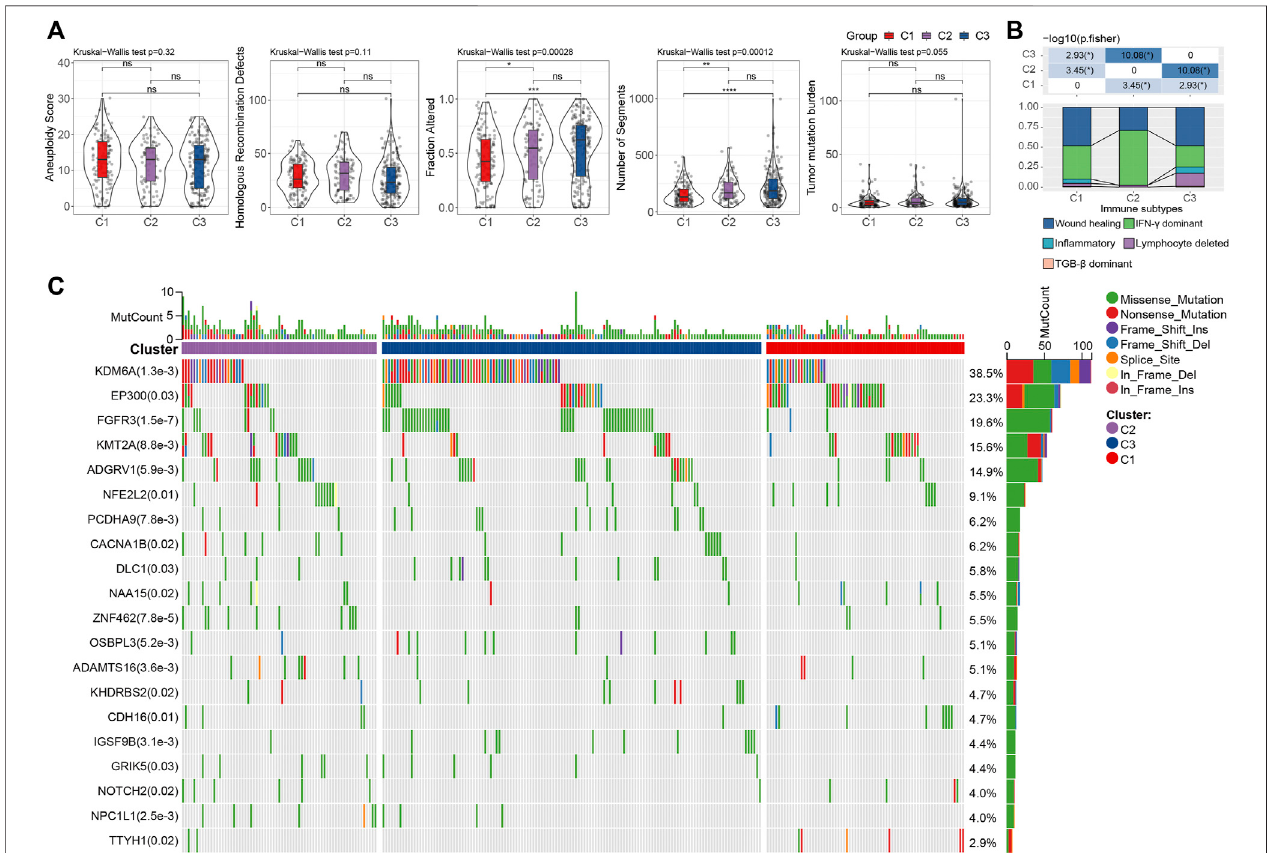
FIGURE 4 | Genomic alternations of LR pairs-based clusters (A) . To differences of aneuploidy score, homologous recombination defects, number of segments, fraction altered, and tumor mutation burden in LR pairs-based clusters. ns, p > 0.05; * p < 0.05; ** p < 0.01; *** p < 0.001. Kruskal-Wallis test. (B) . The fraction of bladder immune subtypes shown in C1, C2, and C3 groups in the TCGA cohort, followed by the corresponding comparison of the numbers in each group (Fisher ’ s exact test). * p < 0.05. (C) Themutationalpro fi lesof404Bladdercancerpatients(top20frequentlymutatedgenes).Top:mutationcountsofthemutatedgenesineachpatient. Bars: LR pairs-based clusters. Right: The types of genetic variants and their frequencies.